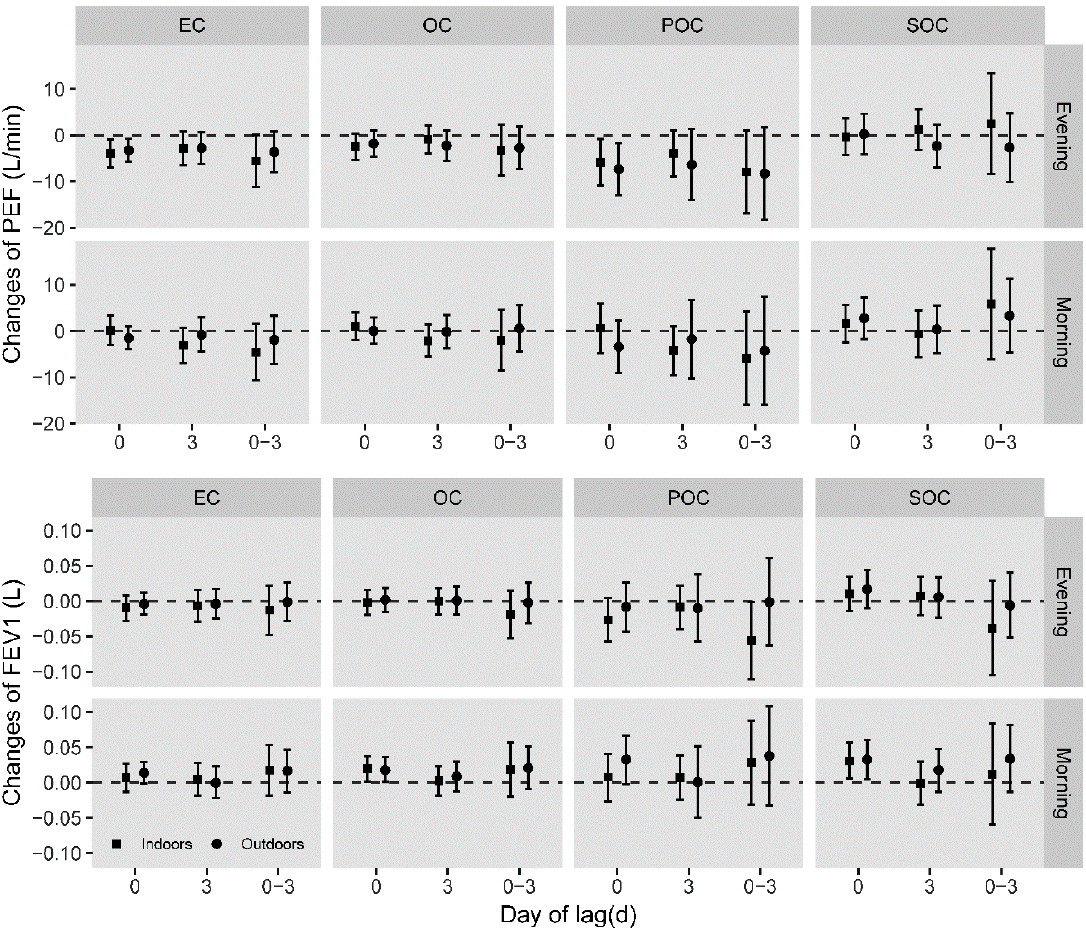
Figure 1. Estimated changes of morning/evening PEF and FEV 1 associated with 10 μ g/m 3 increase of carbonaceous compositions in single-constituent model adjusting for gender, age, height, and season when the measurement was conducted, day of week, day of season, and meteorology. Squares indicate the effects of indoor compositions while circles indicate that of outdoor compositions.